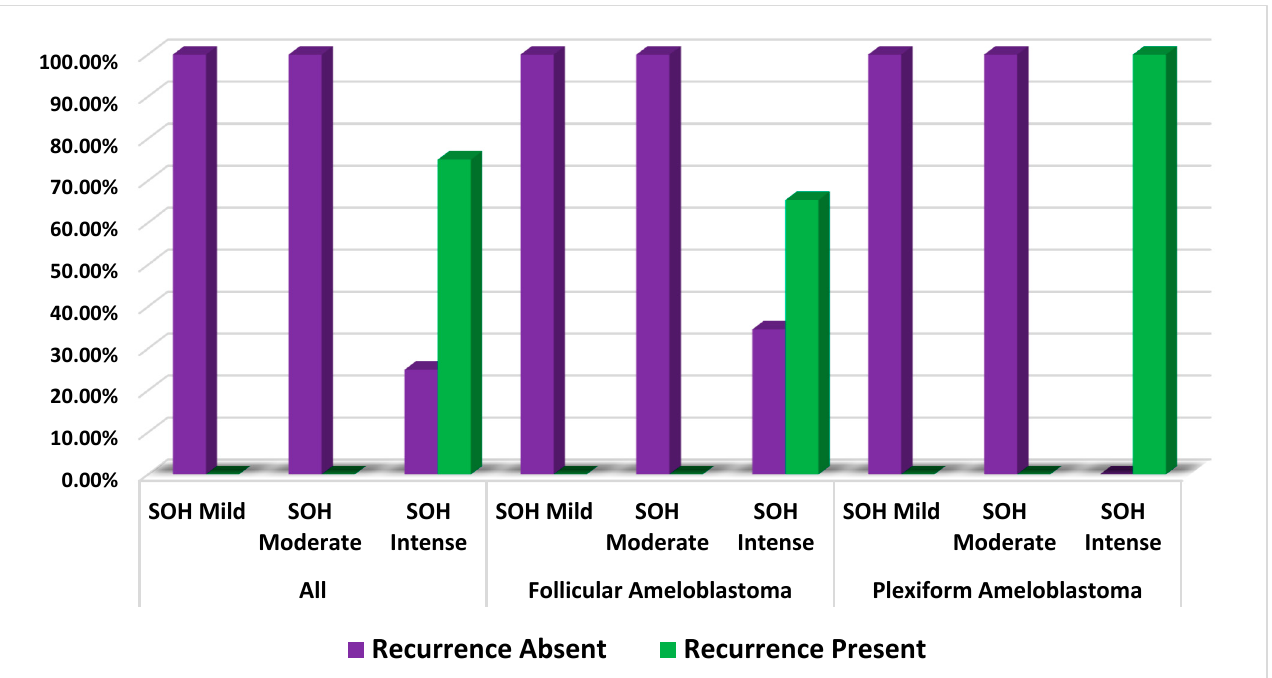
Figure 2. Comparison of correlation of SOH with recurrence of solid multicystic ameloblastoma. This indicates that the histologic subtypes whether follicular or plexiform does not influence the biological behavior of